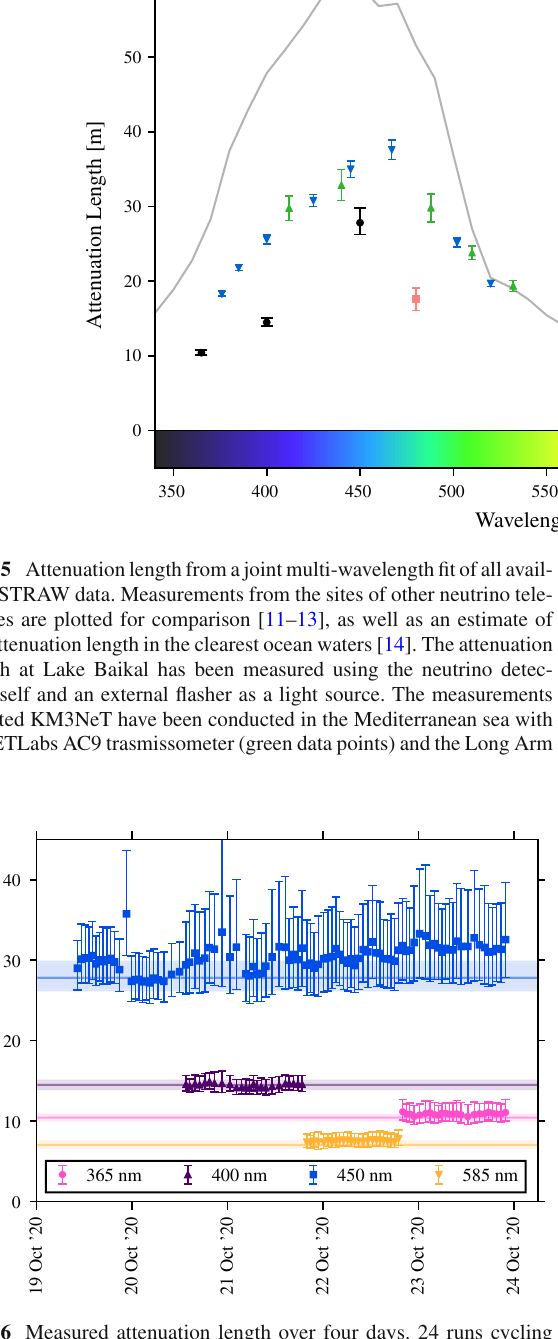
Fig. 6 Measured attenuation length over four days. 24 runs cycling through different flasher intensities have been recorded for each wave- length. Additionally, data were taken at 450nm with a single flasher intensity during the runs at other wavelengths, resulting in larger error bars.Eachrunhasbeenfittedindividually.Theerrorbarsontheindivid- ual runs also reflect the uncertainties of the nuisance parameters and are therefore highly correlated. The solid lines with error bands represent the results from the all-data joint fit (Fig. 5) it was not always possible to extract the flasher signal from the background, as the short absorption length results in